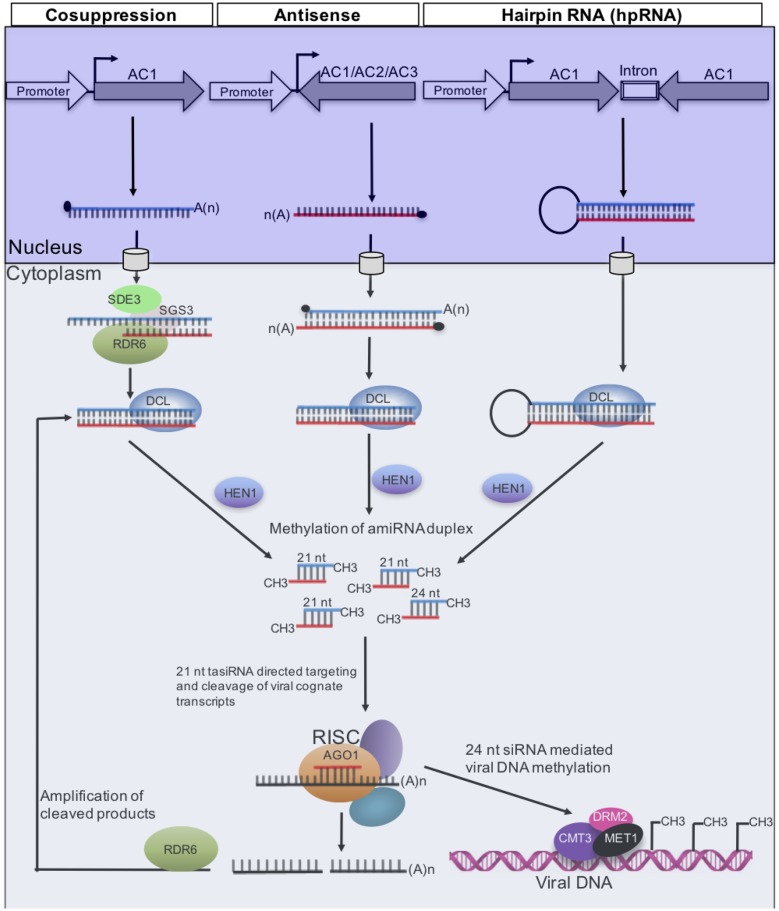
Gene silencing pathways that have been used to generate resistance to CMGs. Long dsRNAs generated from ACMV-KE AC1 (sense) by a member of the RNA-dependent RNA polymerase (RDR) family, or antisense AC1, which binds to AC1 transcripts, or AC1 inverted repeat. In each case, the resulting dsRNA is processed by DCL4 into 21- and 24-nucleotide siRNAs duplexes, which are 2′ O-methylated at the 3′ end by HEN1 prior to entry into the RNA-induced silencing complex (RISC) where there is duplex unwinding. Only one strand of the siRNA duplex associates with the AGO effector protein (Tomari and Zamore, 2005). This guide strand directs to AC1 target by Watson-Crick base pairing; the second siRNA strand is degraded. Methylation of viral DNA is guided by 24-nucleotide siRNAs, a process mediated by DNA methyltransferases MET1, CMT3, and DRM2 (Raja et al., 2008). RNA polymerase RDR6, putative RNA helicase SDE3, coiled-coil protein SGS3, and AGO1 are required for sense transgene, but not for hpRNA PTGS (Wassenegger and Krczal, 2006; Diaz-Pendon et al., 2007).